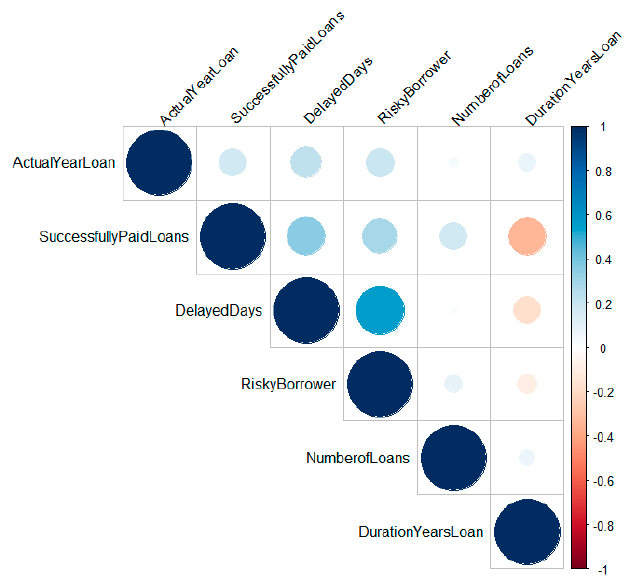
Figure 9. Correlation analysis of features.